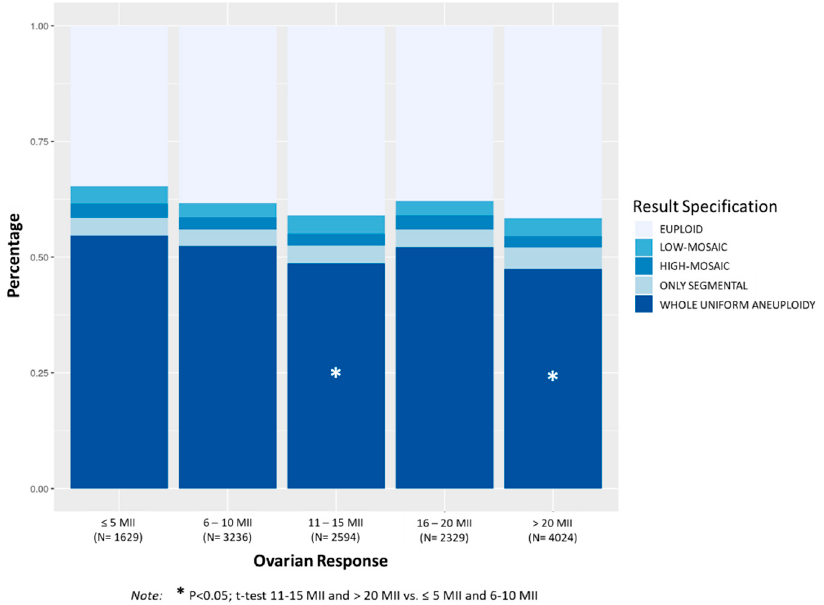
Figure 2. Distribution of chromosomal abnormalities in TE biopsies (euploid, low-mosaic, high-mosaic, only segmental, and whole uniform aneuploidy) according to categories of ovarian response considering the number of mature oocytes retrieved ( ≤ 5 MII oocytes; 6–10 MII oocytes; 11–15 MII oocytes; 16–20 MII oocytes; >20 MII oocytes). The mean number of embryos biopsied (SD) per case was 2.6 (1.9) for ≤ 5 MII oocytes category, 3.4 (2.1) for 6–10 MII, 4.5 (2.9) for 11–15 MII, 4.8 (2.7) for 16–20 MII and 6.5 (3.9) for >20 MII oocytes category.